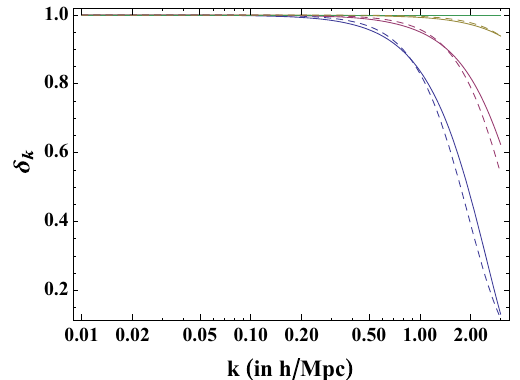
Fig. 4 Perturbations, δ k , in the non-canonical scalar field model are shown at the present epoch. δ k is plotted against k for α = 2 × 10 7 , 7 × 10 7 , 5 × 10 8 ( bottom to top , solid lines ). Perturbations in warm dark matterconsistingofasterileneutrinowithmass = 0 . 5 , 1 , 3KeVarealso shown( bottom to top , dashedlines ).The topmostsolidline corresponds to (cid:4)